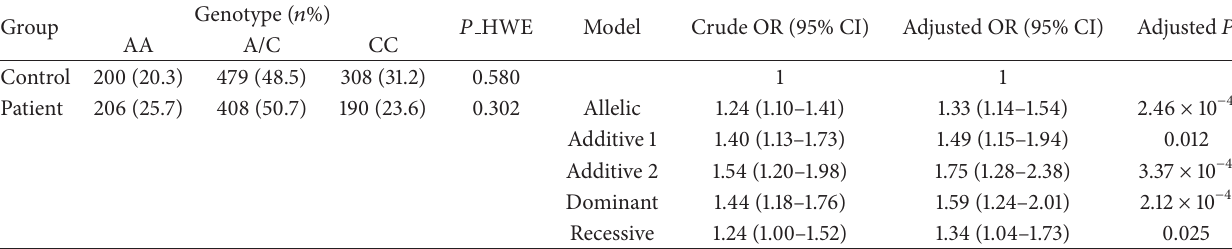
Table 3: The SNP of rs9307551 in the LOC100506035 gene was associated with HM in this study.